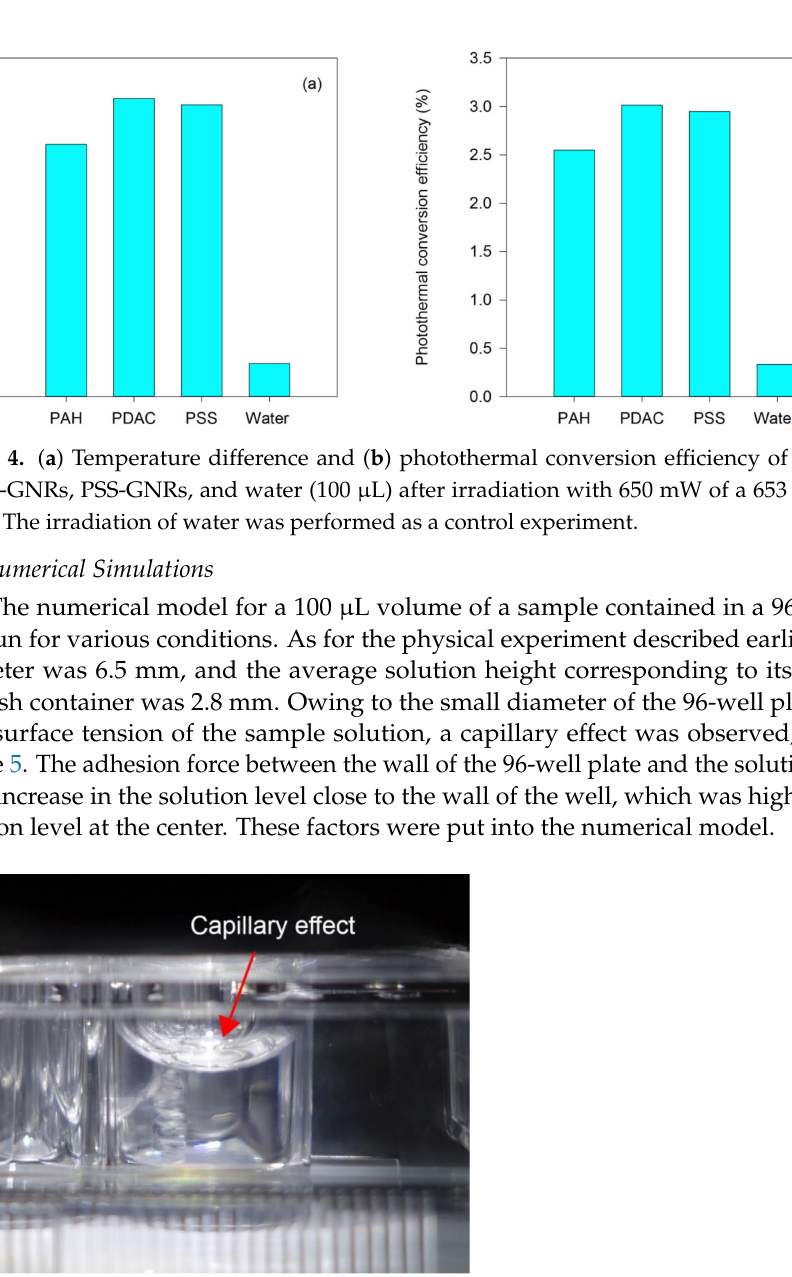
Figure 5. Capillary effect of the solution after the solution was pipetted into the well of a 96-well